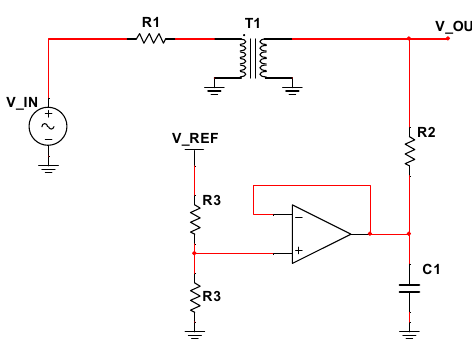
Figure 4. Simplified circuit topology of the voltage channel conditioning stage.